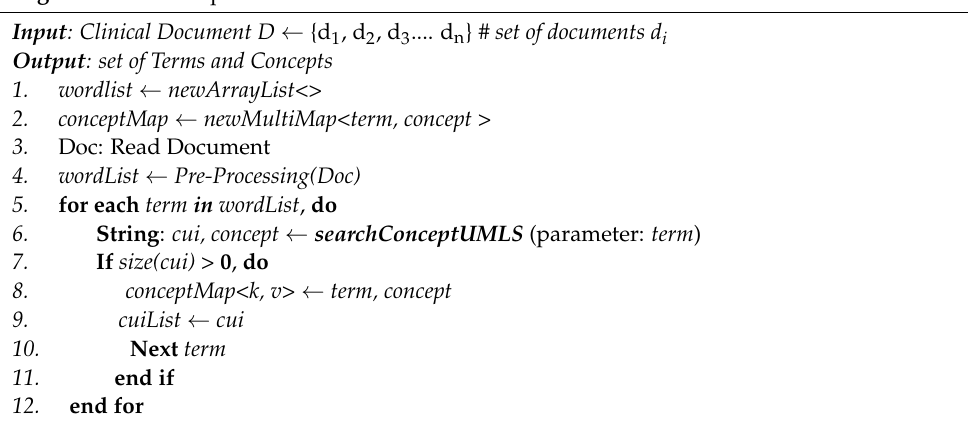
Algorithm 2 : Concept Identification from UMLS.